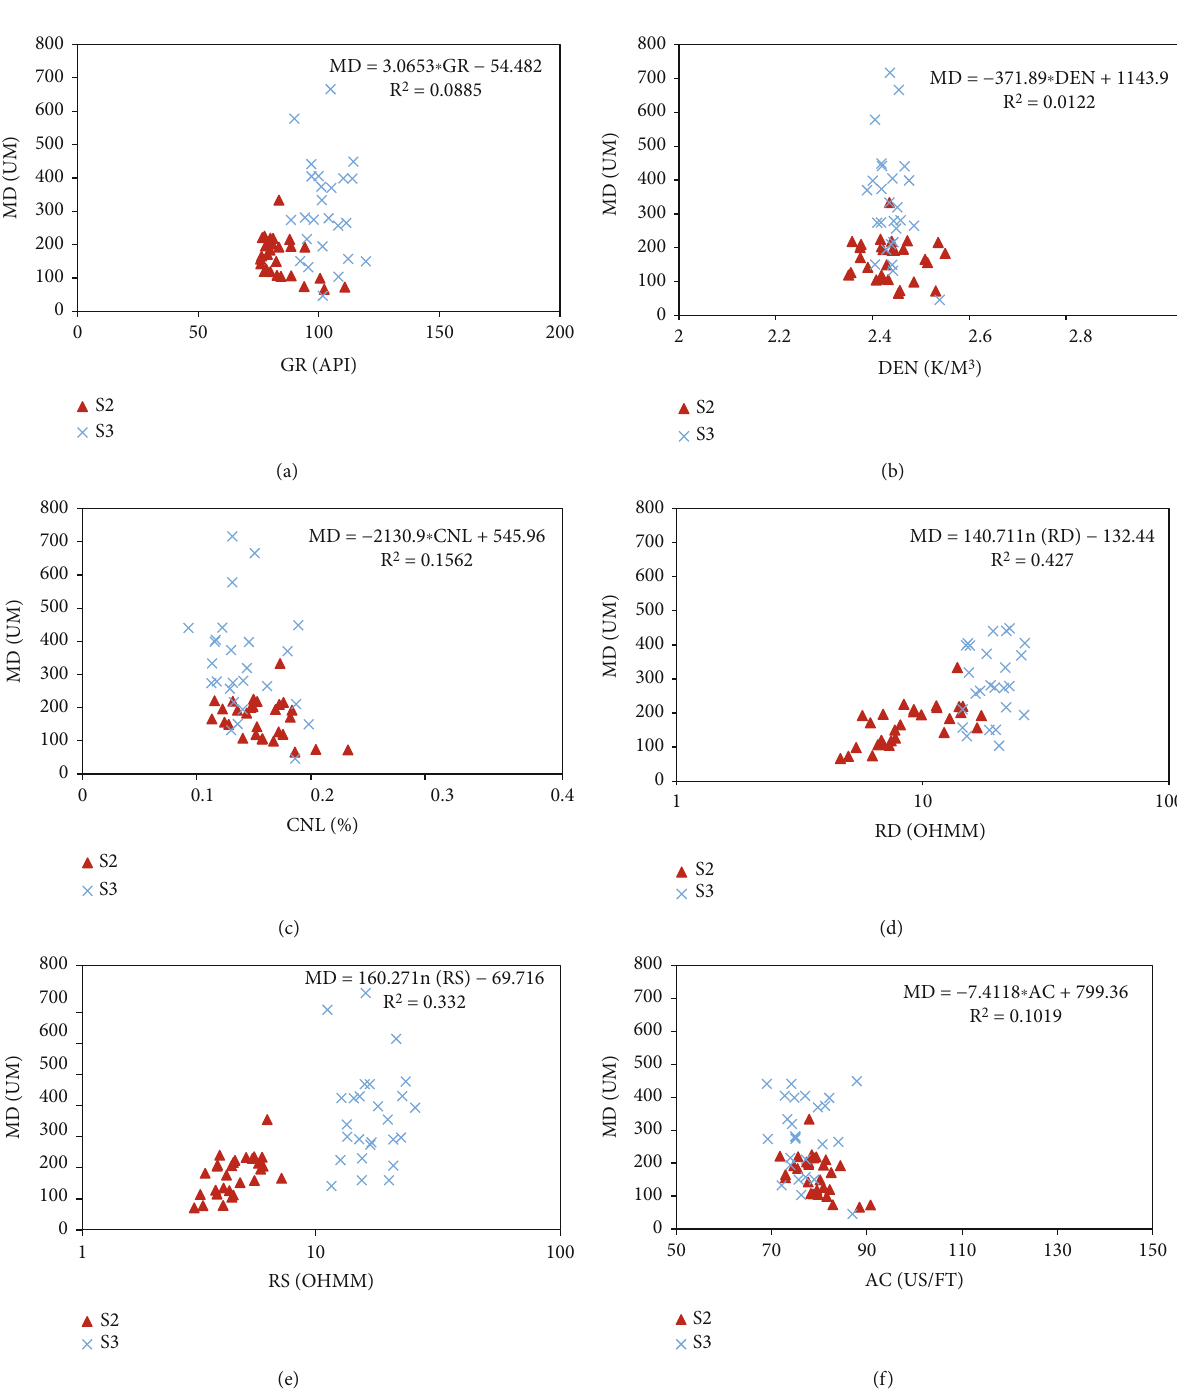
and S sections of well 2 3